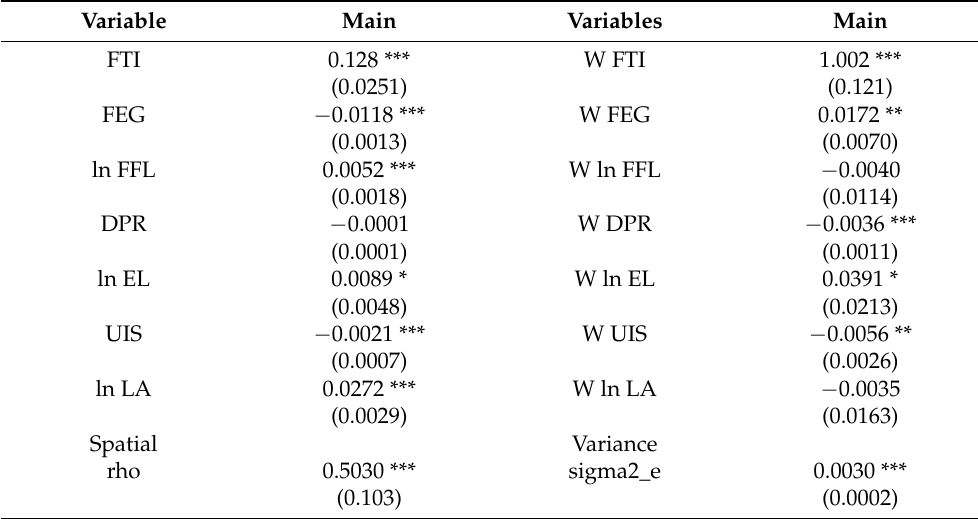
Table 5. Spatial Durbin model parameter estimation